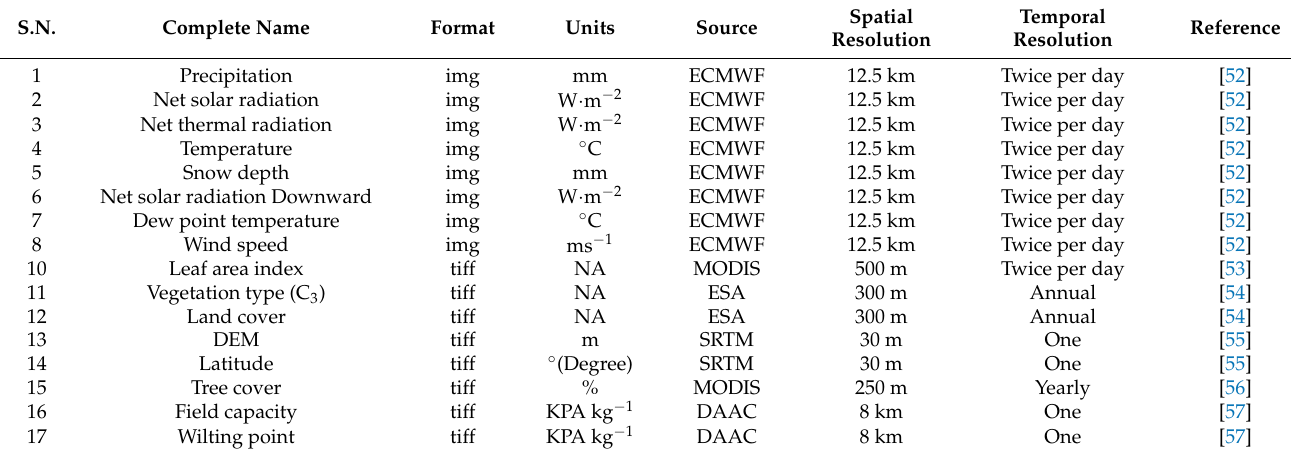
Table 2. List of major parameters of BEPS model, their source, and spatiotemporal extent. ECMWF, European Centre for Medium-Range Weather Forecasts; MODIS, Moderate Resolution Imaging Spectroradiometer; ESA, European Space Agency; SRTM, Shuttle Radar Topography Mission; DAAC, Distributed Active Archive Center.